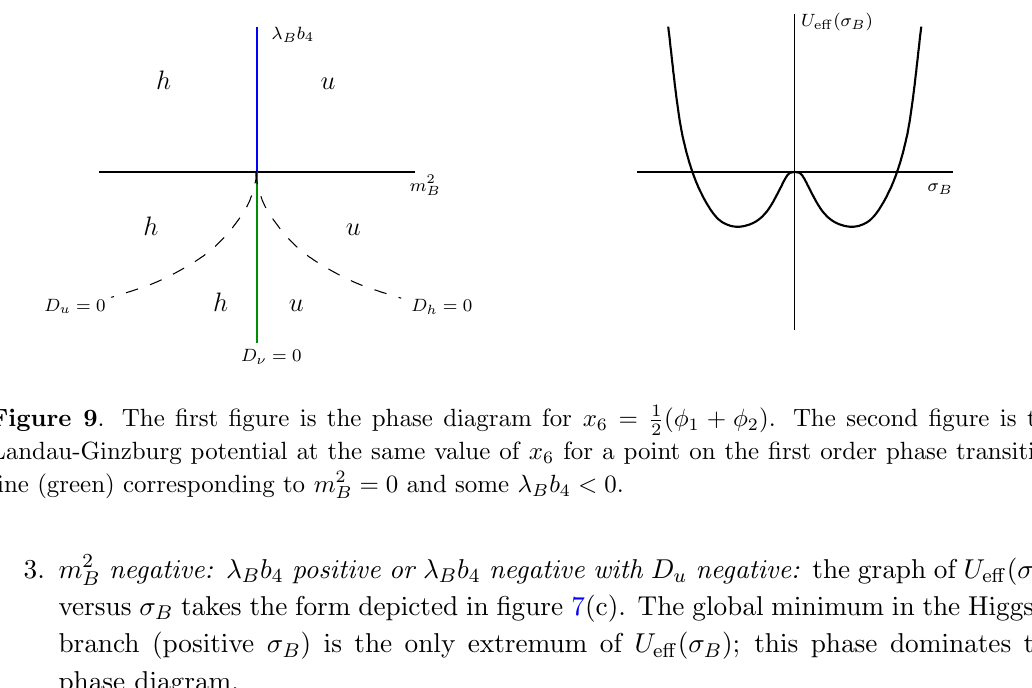
( (cid:27) ) B e(cid:11)